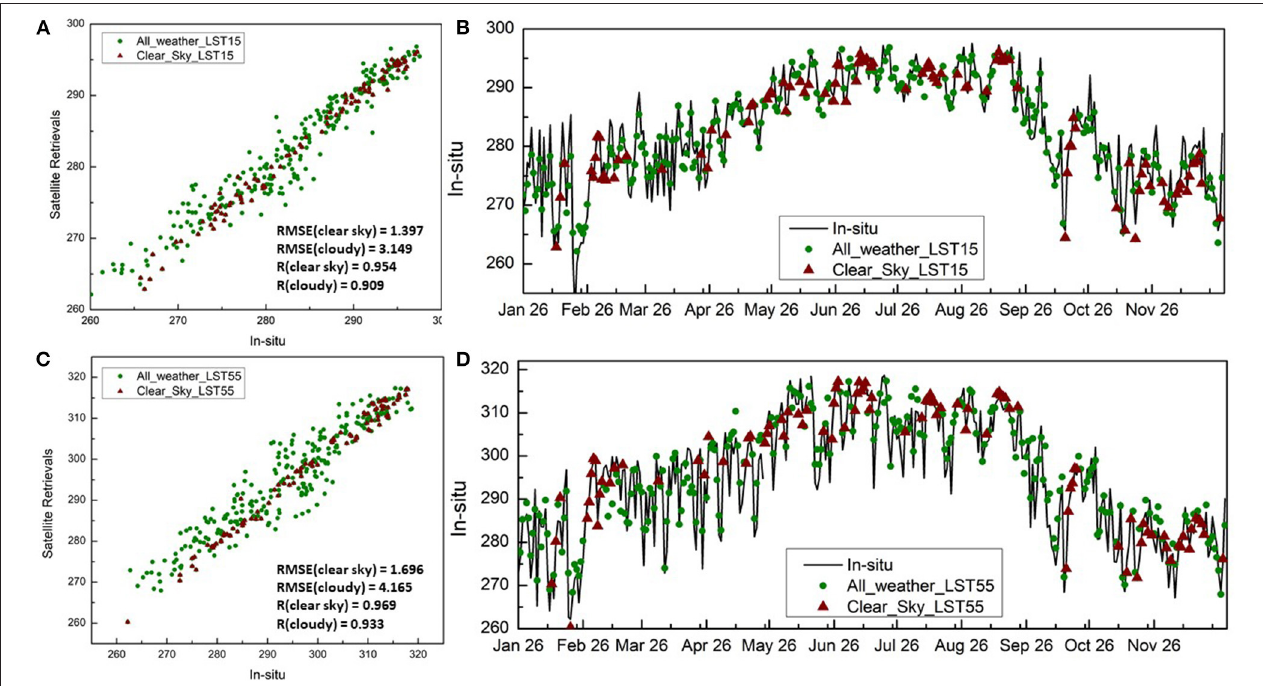
FIGURE 6 | Scatter plot (A,C) and time series (B,D) comparison of clear-sky LST (based on GOES16/17 only) and all-weather LST (based on combined GOES/AMSR2/CFSR), along with in-situ LST measurements over the SURFRAD-TBL station; (A,B) comparison at Time 1 (1.5 hour after sun rise) and (C,D) comparison at Time 2 (1.5 hour before noon); Unit: